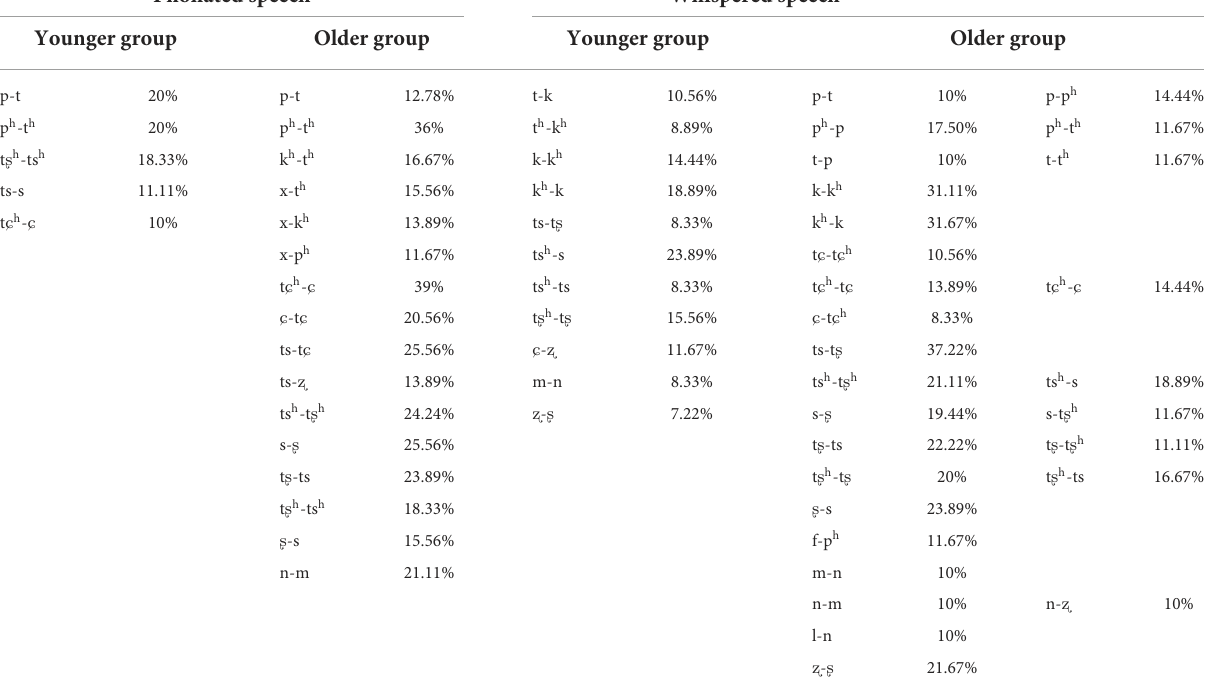
TABLE 1 Most frequently confused pairs and their error percentage for two groups in two articulatory modes. Phonated speech Whispered speech Younger group Older group Younger group Older